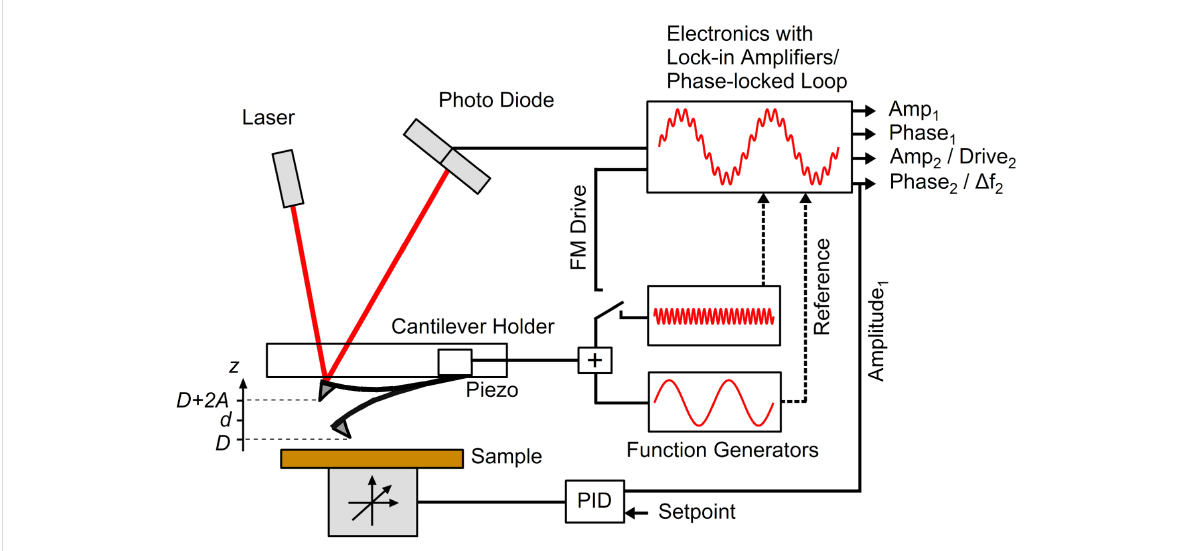
Figure 1: Schematic setup of our AFM operated in AM-OL or AM-FM mode. AM-OL mode can be accomplished by adding the drive signals of two function generators for exciting the cantilever beam and using two lock-in amplifiers to track the amplitudes and phase shifts at the corresponding eigenmodes. For AM-FM mode external PLL electronics were used, which provided a drive signal with a constant phase shift of 90° between excita- tion and response while tracking changes in the instantaneous resonant